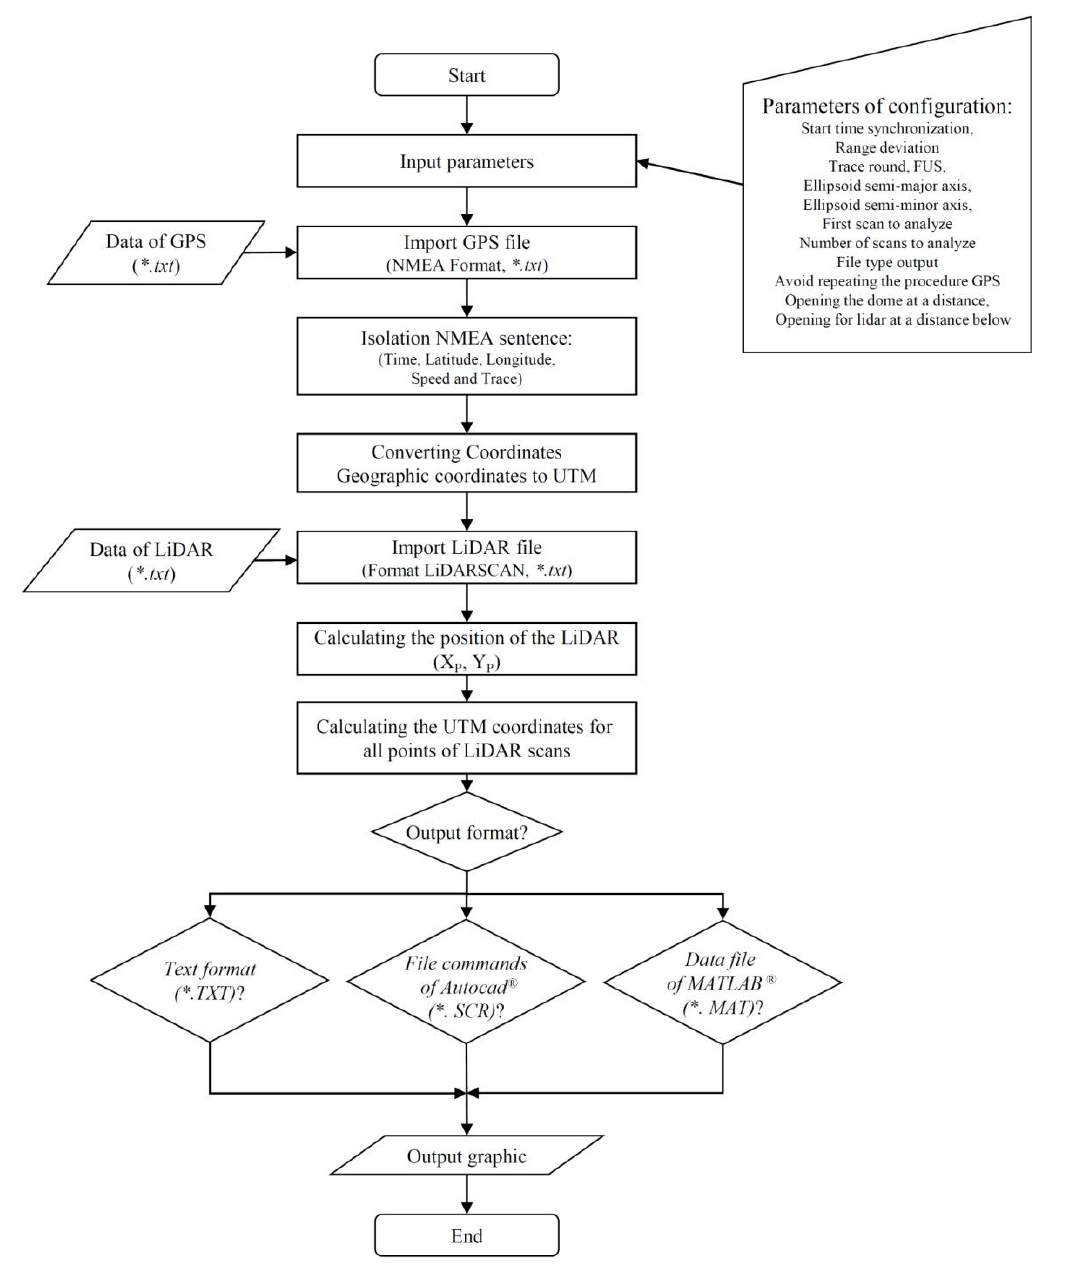
Figure 6. Flow chart of the first part of the georeferencing